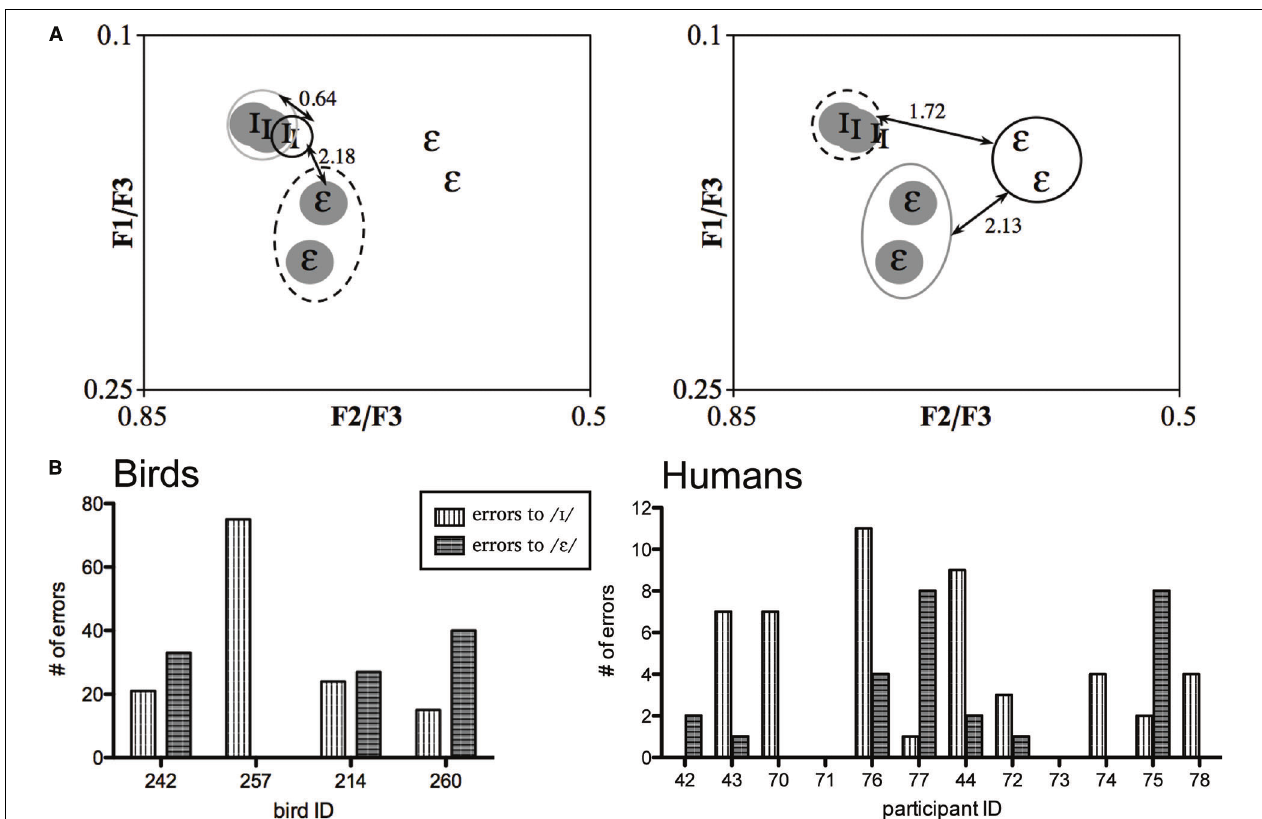
FIGURE 5 | Acoustic distances between vowel categories of FAM and NEW (gray) after transformation into formant ratios according to Monahan and Idsardi (2010; A), and the number of errors individuals tested on this speaker set made when classifying NEW /  / and / " /